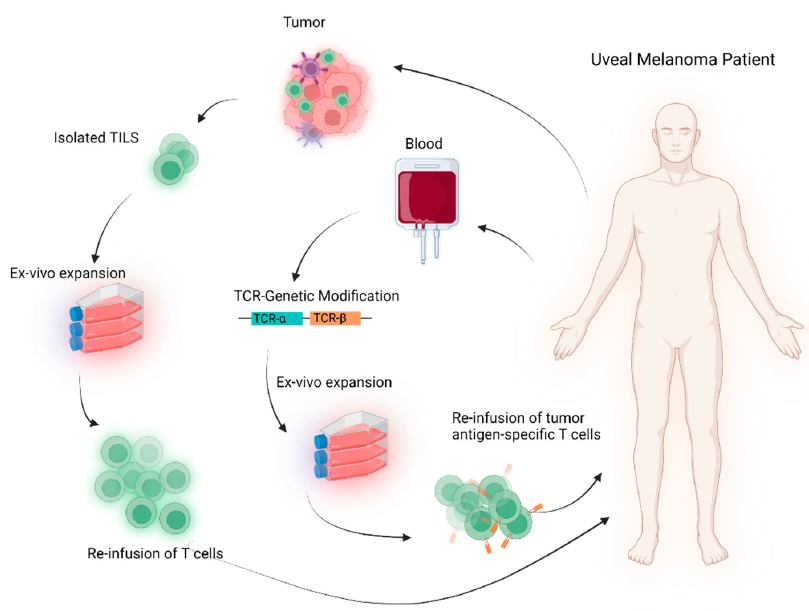
Figure 1. Schematic representation of TCR-based cellular therapies in mUM